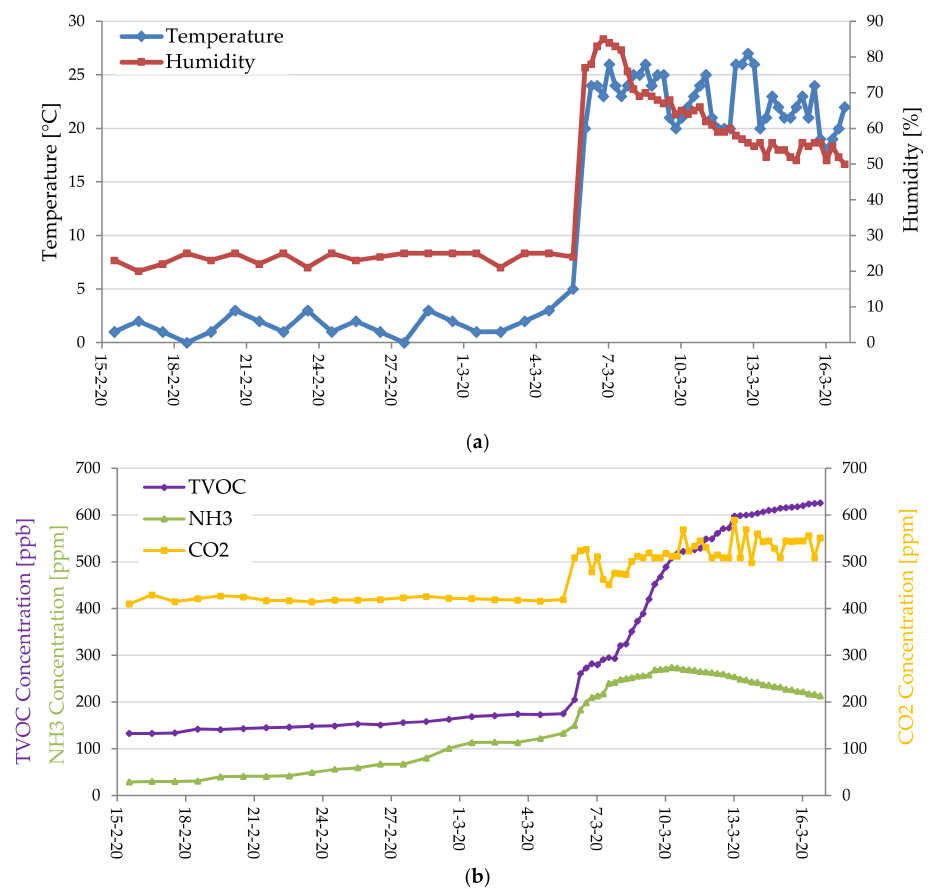
Figure 23. Temporal trends of the parameters detected by the BLE tag applied to the box with inside 500 g of codfish fillets during 30-day-long period. ( a ) Temperature and humidity; ( b ) TVOC, NH 3 and CO 2